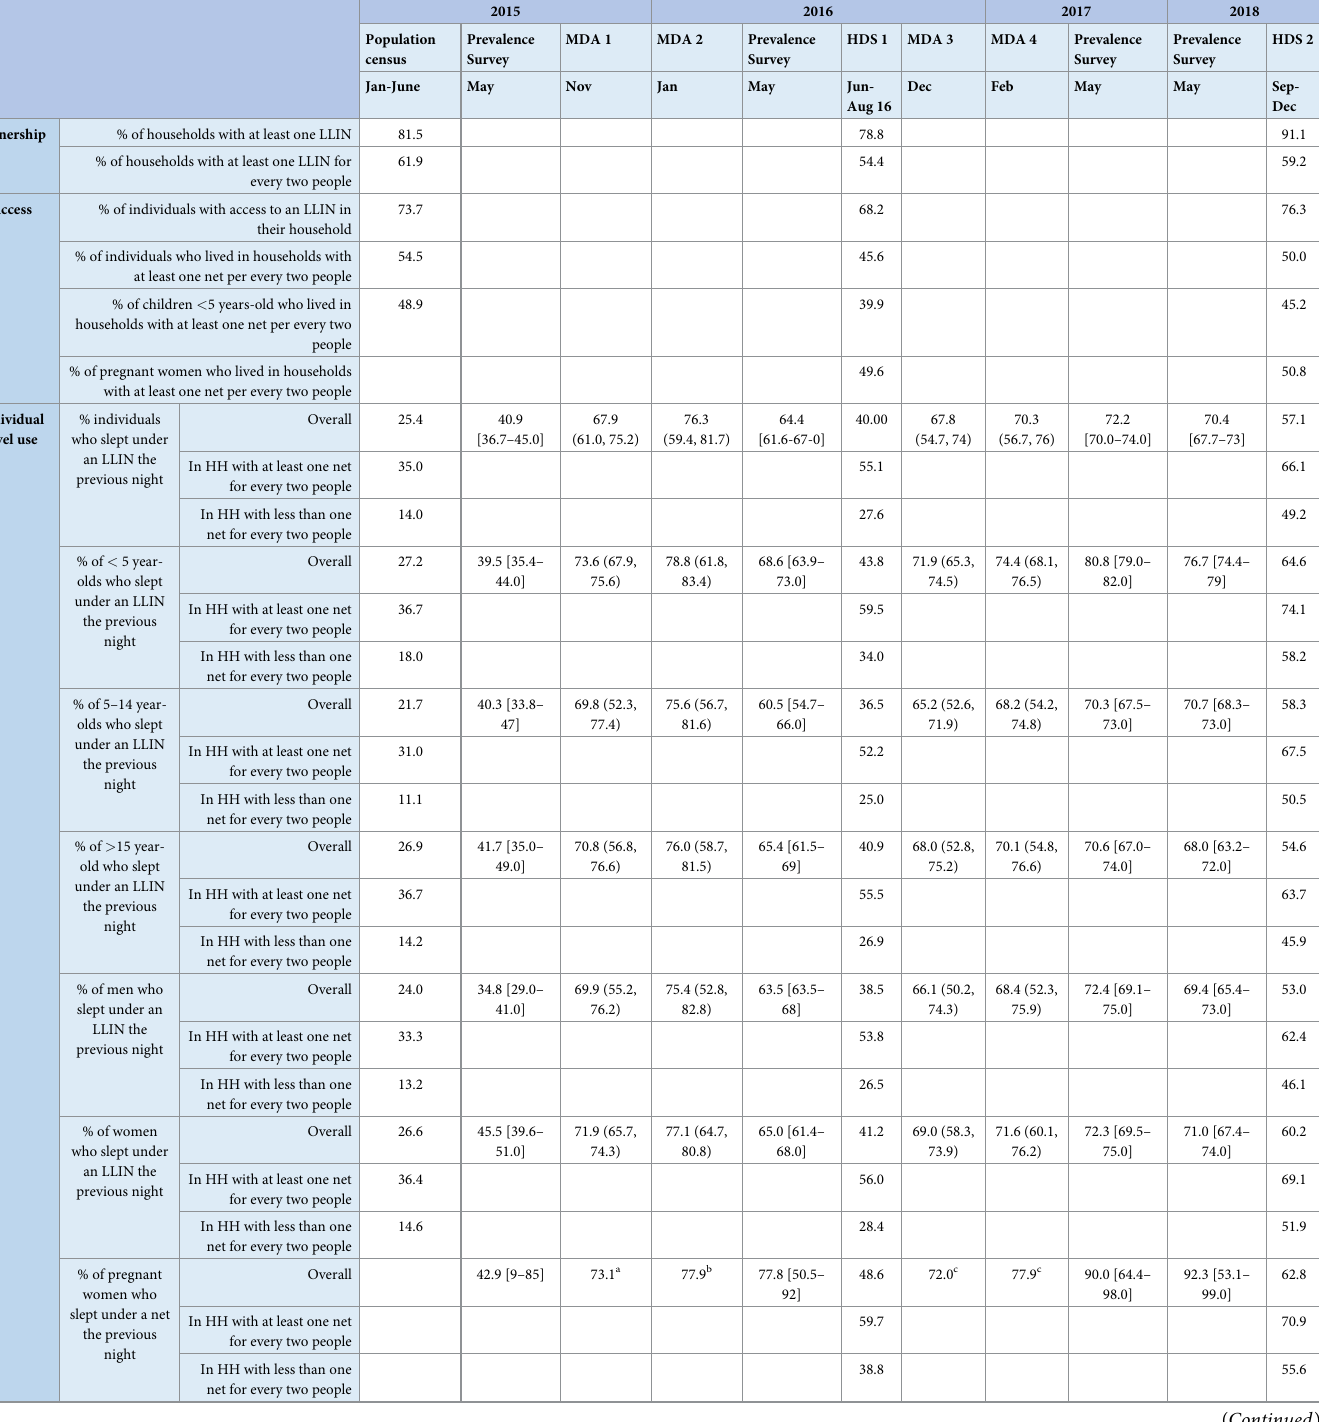
Table 2. LLIN ownership, access, use, use provided access and use among sprayed and unsprayed household throughout the Magude project. Indicators estimated from MDA surveys are presented with their best-case and worst-case estimates in parenthesis. Confidence intervals for indicators estimated from the malaria prevalence cross-sectional surveys are calculated with survey methods taking into consideration individual weights based on their age-strata and are presented in square brackets. No confidence intervals are provided for indicators calculated from the census or demographic and health surveys, as these covered the entire population in the